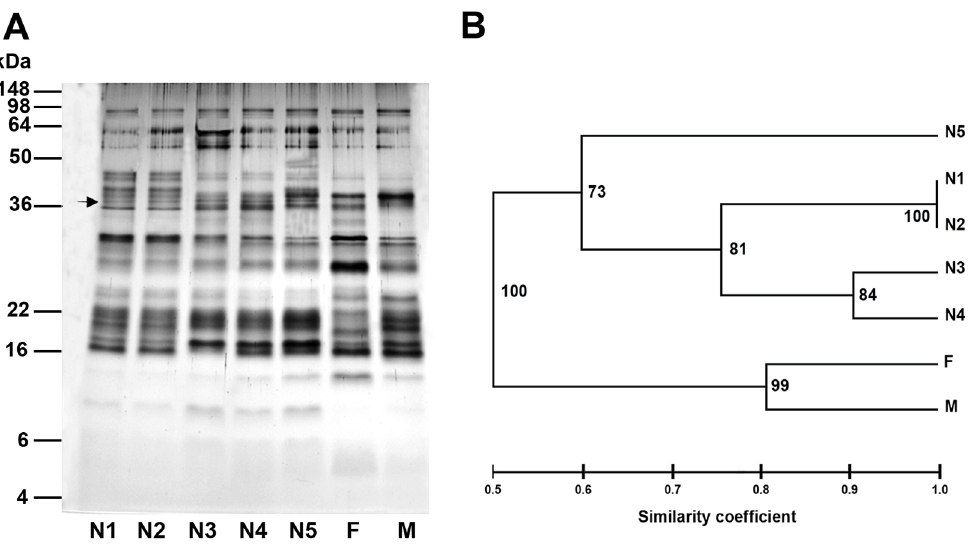
Figure 1. Salivary profiles of the developmental stages of T.infestans . (A) Proteins in crude saliva of all nymphal (N1–N5) and adult (female, F and male, M) stages of a Bolivian T. infestans strain were separated by SDS-PAGE. A nymphal-specific salivary protein of 37 kDa is marked with an arrow. (B) An unrooted phenogram of the salivary profiles was constructed using the UPGMA method of the FreeTree software [50]. Bootstrap values are displayed at the nodes of the tree and the scale bar represents the Dice’s similarity coefficient.